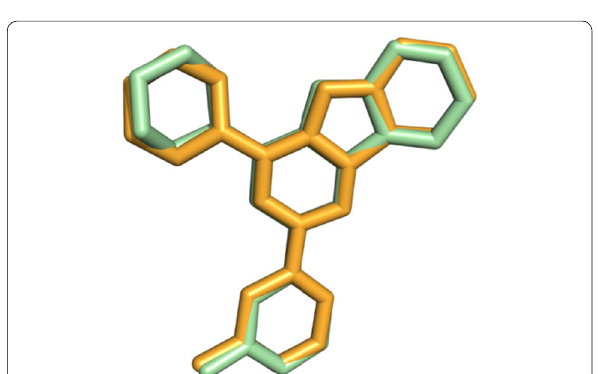
Fig. 6 The superposition of KWT QPLD‑docked pose and its native conformation in 3HHM. The native coordinates are represented in orange and the docked pose in green color. Picture visualized by